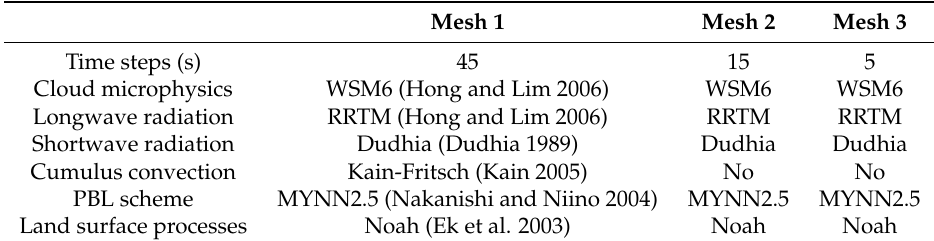
Table 5. WRF model